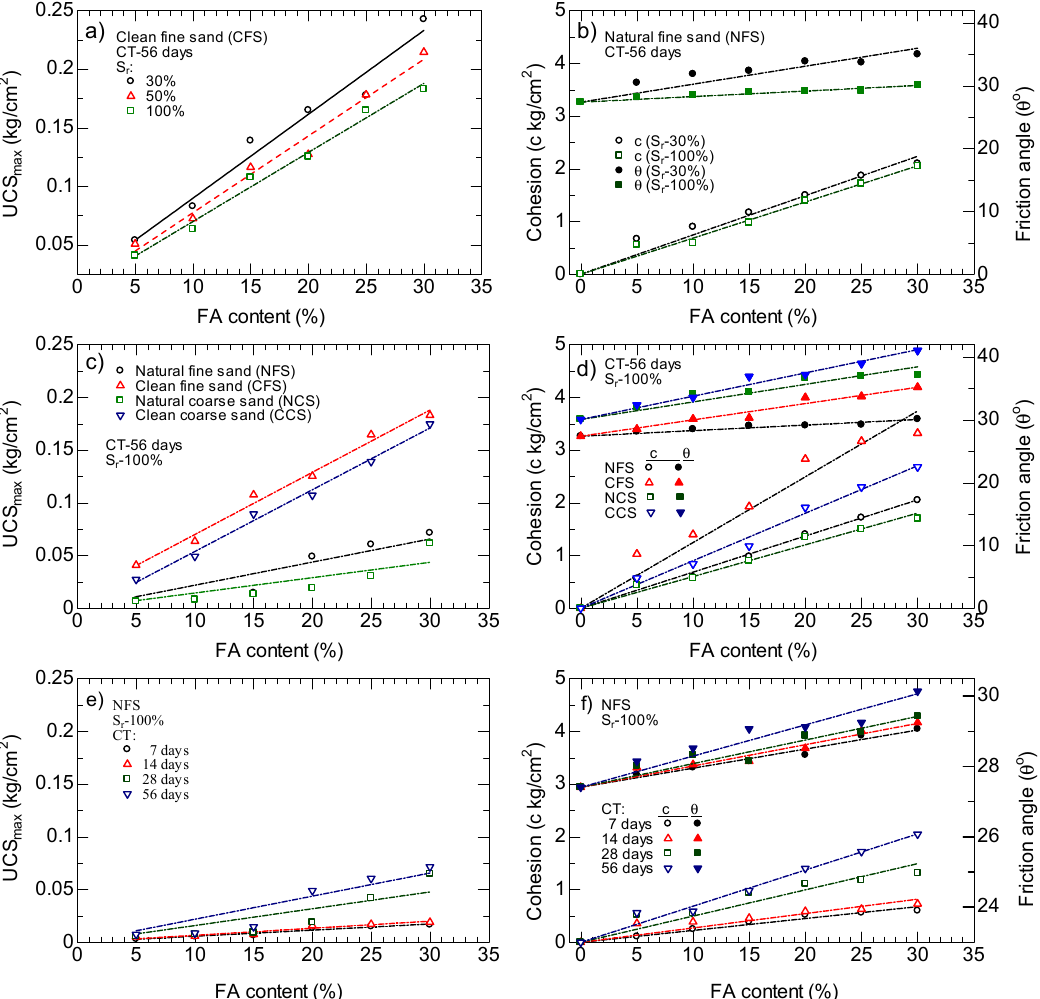
Figure 4. The e ff ect of fly ash percentages on the mechanical properties of fly-ash-stabilized sand. ( a ) UCS max -FA relationship of CFS at various S r with CT-56 days, ( b ) shear strength parameters-FA relationship of NFS at di ff erent S r with CT-56 days, ( c ) UCS max -FA relationship of dissimilar sands with S r -100% and CT-56 days, ( d ) shear strength parameters-FA relationship of diverse sands with S r -100% and CT-56 days, ( e ) UCS max -FA relationship of NFS at various CT with S r -100%, ( f ) shear strength parameters-FA relationship of NFS at any kinds of CT with S r -100%.